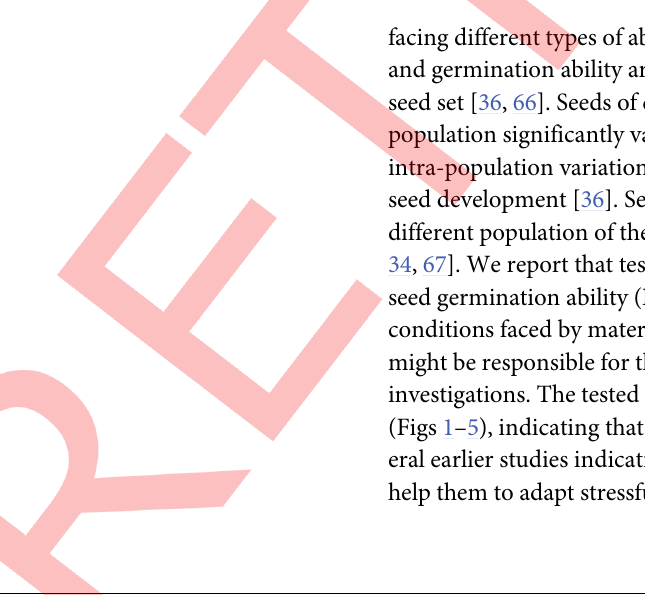
PLOS ONE | https://doi.org/10.1371/journal.pone.0241601 October 30,